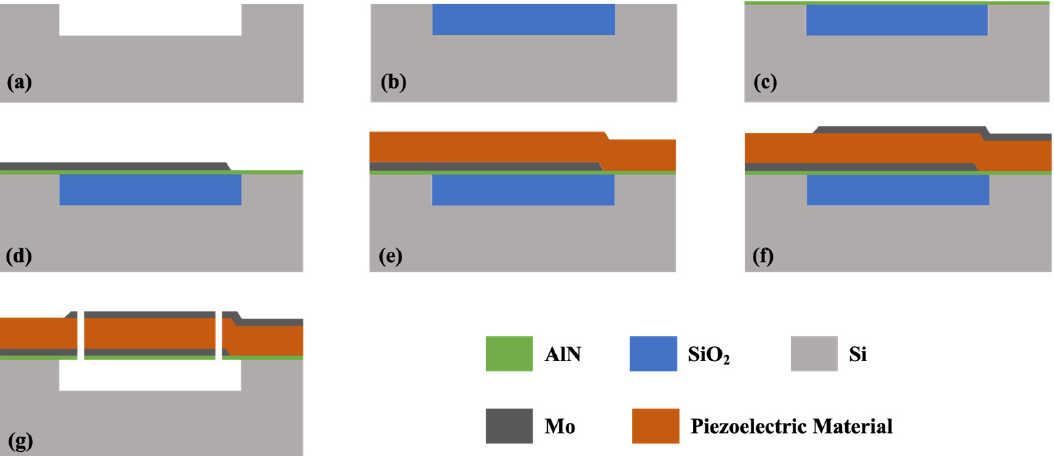
Figure 2. Schematic of process flow. ( a ) Si substrate with a cavity; ( b ) Cavity filled with SiO 2 ; ( c ) AlN seed layer deposition; ( d ) Mo bottom electrode deposition and patterning; ( e ) Piezoelectric material sputter-deposition; ( f ) Mo top electrode deposition and patterning; ( g ) Releasing cavity.